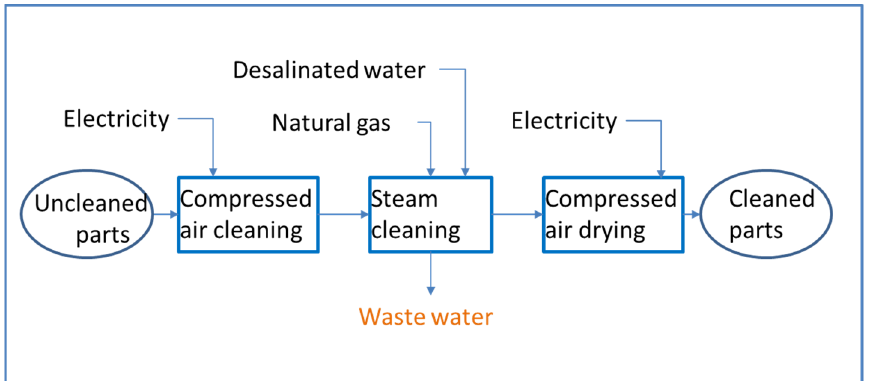
Figure 4. The processes of the cleaning phase.